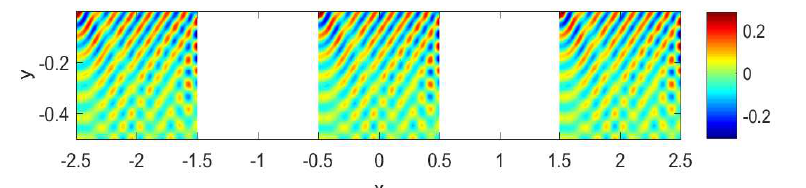
Figure 8. Contour for real part of the magnetic field by three empty cavities with k 0 = 8 π m − 1 of 512 × 256 mesh at θ = π /3.